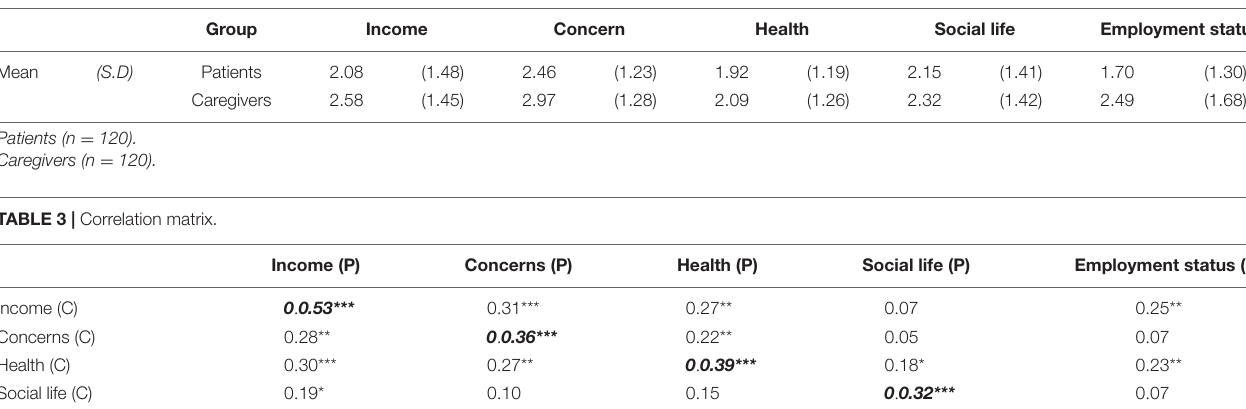
TABLE 2 | Descriptives of the areas of concern.